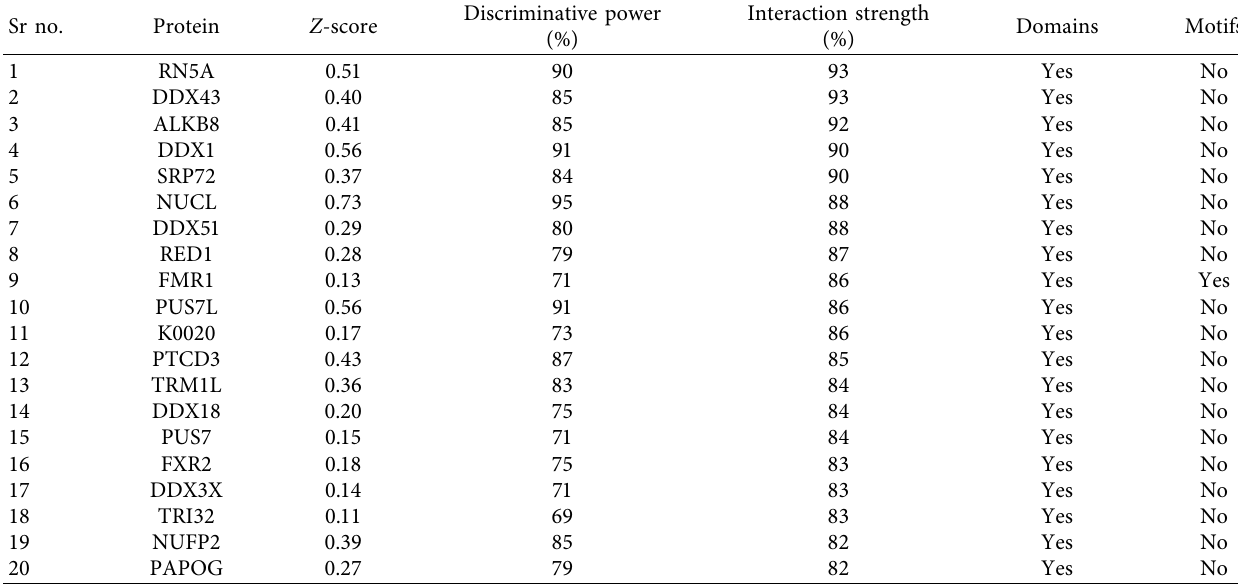
Table 3: CatRAPID profling suggests that various RBPs interact with UTRs. 5 ′ UTR catRAPID profle: list of RBPs interacting with SARS-CoV-2 5 ′